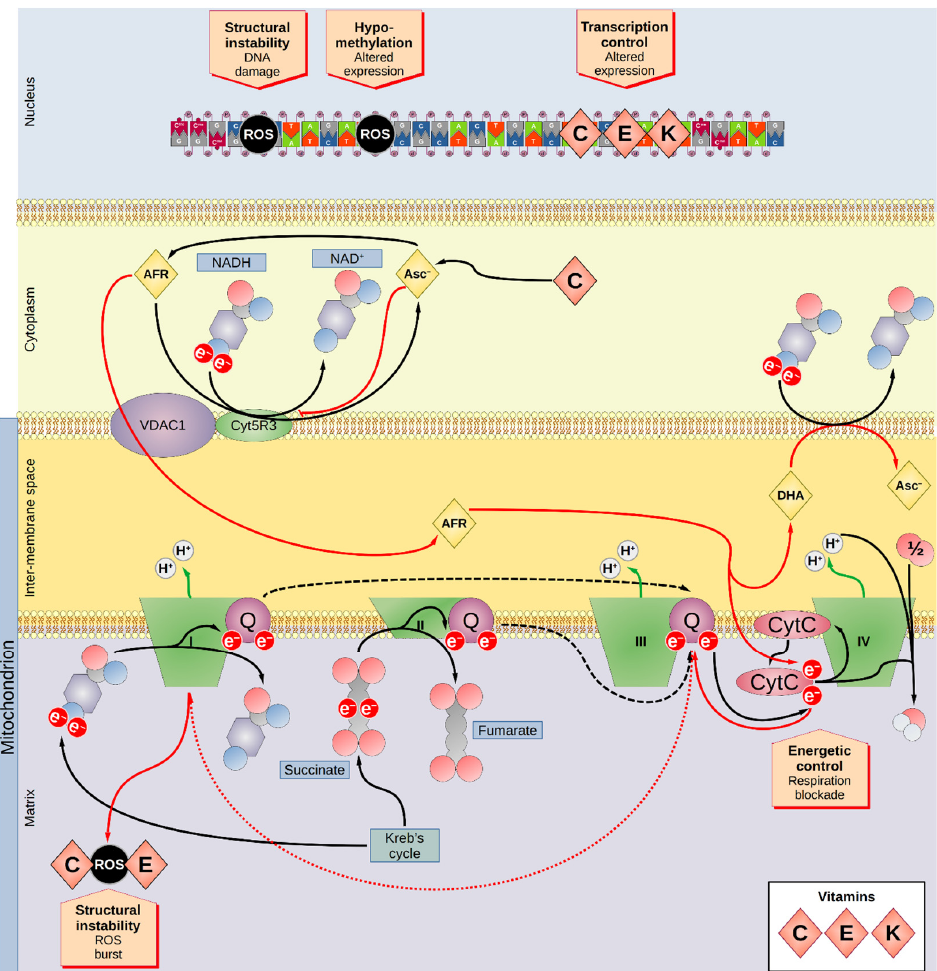
Figure 2. Overview of the impact of vitamins C, E, and K on the cellular biochemistry. Vitamins C and E as well as most minerals affect the cellular biochemistry mainly by altering the oxidative status of the cells. Vitamin C is converted rapidly to Asc − and AFR. The Krebs cycle produces high energy molecules such as NADH, FADH 2 , ATP, or succinate. The Krebs cycle is linked to the respiration process that occurs mainly on the inner membranes of mitochondria, where several multiprotein complexes (I-IV) extract electrons from the high-energy molecules to pump protons (H + ) into the intermembrane compartment of the mitochondria (third compartment of the figure). Protons are then pumped back into the cytoplasm producing ATP. In particular, complex I (NADH-ubiquinone oxidoreductase) oxidizes NADH to NAD + , and complex II (succinate-CoQ reductase) oxidizes succinate to fumarate, yielding FADH 2 . The acquired electrons are transferred to ubiquinone (also known as CoQ), which translocates them to complex III, which modulates the transfer of the electrons from CoQ to CytC, which then transfers them to complex IV (cytochrome c oxidase). Complex IV converts O 2 to H 2 O in presence of H + . Under physiological conditions, the enzyme Cyb5R3 transfers one electron (e − ) from NADH to AFR, producing Asc − and NAD + . An excess of Asc − , however, inhibits Cyb5R3 and the Cyb5R3-associated membrane pump VDAC1 transfers AFR into the intermembrane compartment, which then transfers an electron directly to CytC, blocking the respiratory process. Incapable of reaching complex IV, the electrons in the transfer chain proceed back to complex I, producing a burst of ROS (dotted red arrow). Furthermore, AFR is converted into DHA that is then reduced to Asc − , producing NAD + . The newly produced Asc − then further inhibits Cyb5R3 and the excess NAD + can shift the balance of the reactions taking place in the Krebs cycle (red arrow). However, vitamins C and E act as scavengers neutralizing ROS. Vitamins C, E, and K can modulate the expression of several genes. ROS can directly damage the DNA chain,